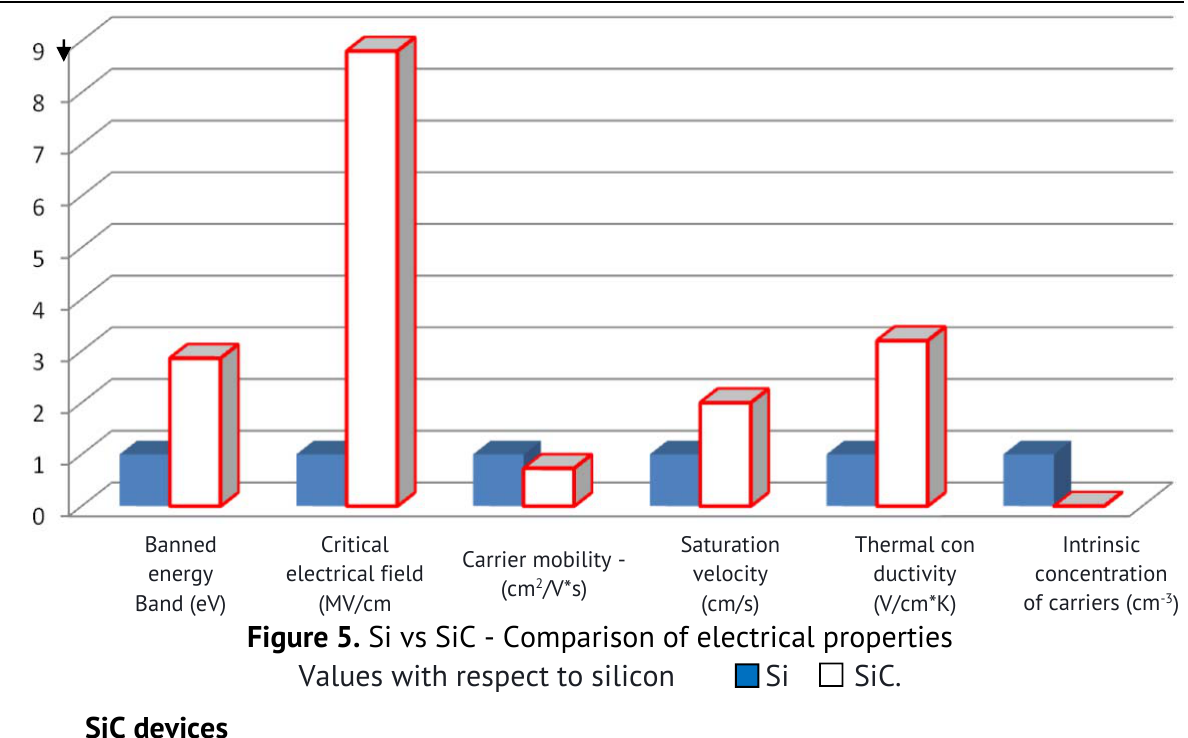
Figure 5. Si vs SiC - Comparison of electrical properties Values with respect to silicon Si SiC. SiC